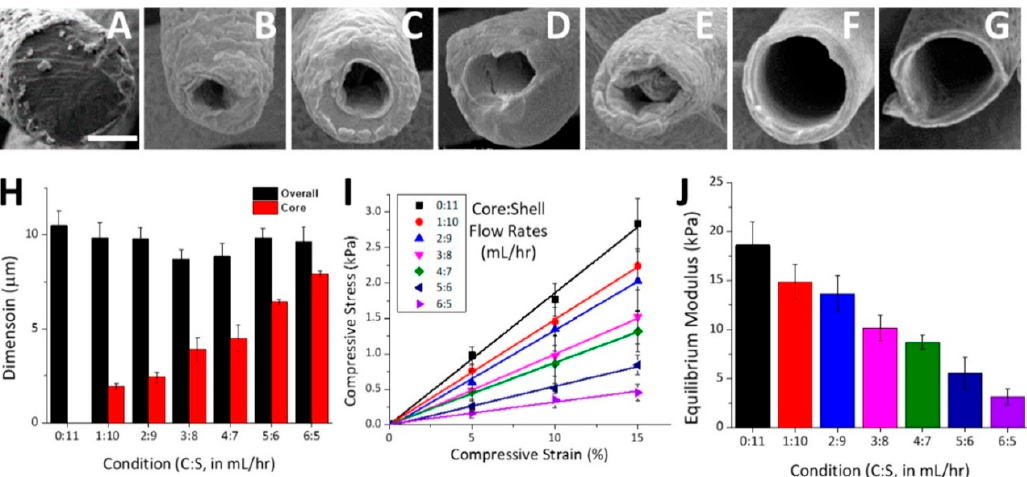
Figure 10. Adjustment of the mechanical properties of electrospun fibres. SEM images of the cross-sections of hollow fibres fabricated by varying the core (PEG):shell (PCL) polymer flow rate ratios (in mL/h) during coaxial electrospinning: ( A ) 0:11, ( B ) 1:10, ( C ) 2:9, ( D ) 3:8, ( E ) 4:7, ( F ) 5:6, and ( G ) 6:5. Scale bar: 5 μ m. The PEG core was subsequently removed using PBS. ( H ) Overall and core diameters of the hollow fibres for each core:shell flow rate ratio. ( I ) Representative compressive stress-strain curves from electrospun scaffolds (3 mm thickness) fabricated with the different hollow fibres displayed in ( A – G ). ( J ) Equilibrium moduli of electrospun scaffolds demonstrate that the mechanical properties decrease substantially for higher core flow rates (since these result in a larger hollow compartment after PEG leaching). Reprinted with permission from [297]. Copyright © 2019, American Chemical Society.